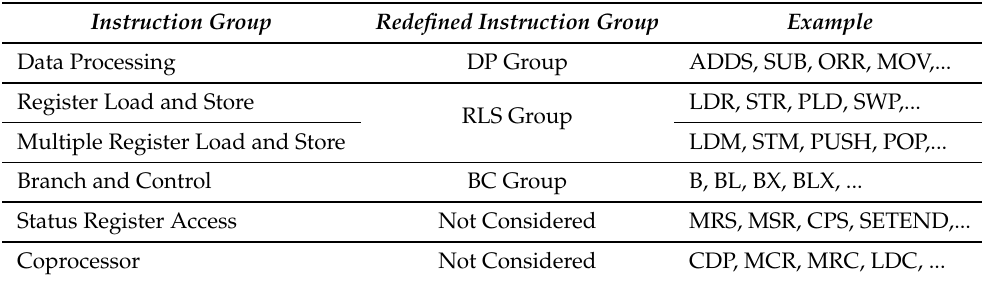
Table 2. Group of ARM instruction